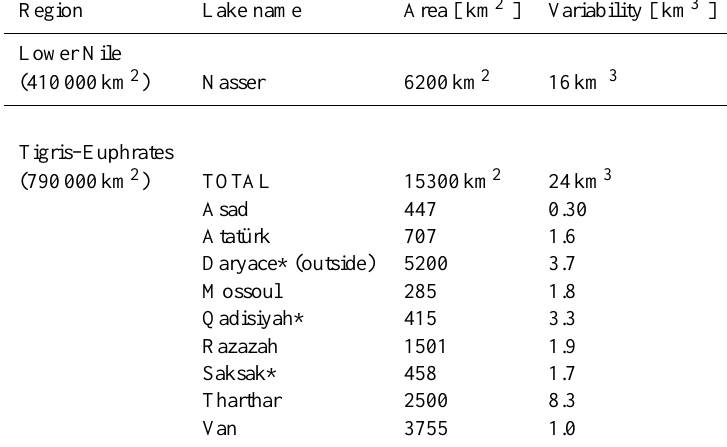
Table 1. Lake and reservoir data summary. Variability is computed as the standard deviation of lake storage variations over the whole time series. Asterisks refer to reservoirs and lakes that have volume data in the Hydroweb database; for other lakes, we assume constant